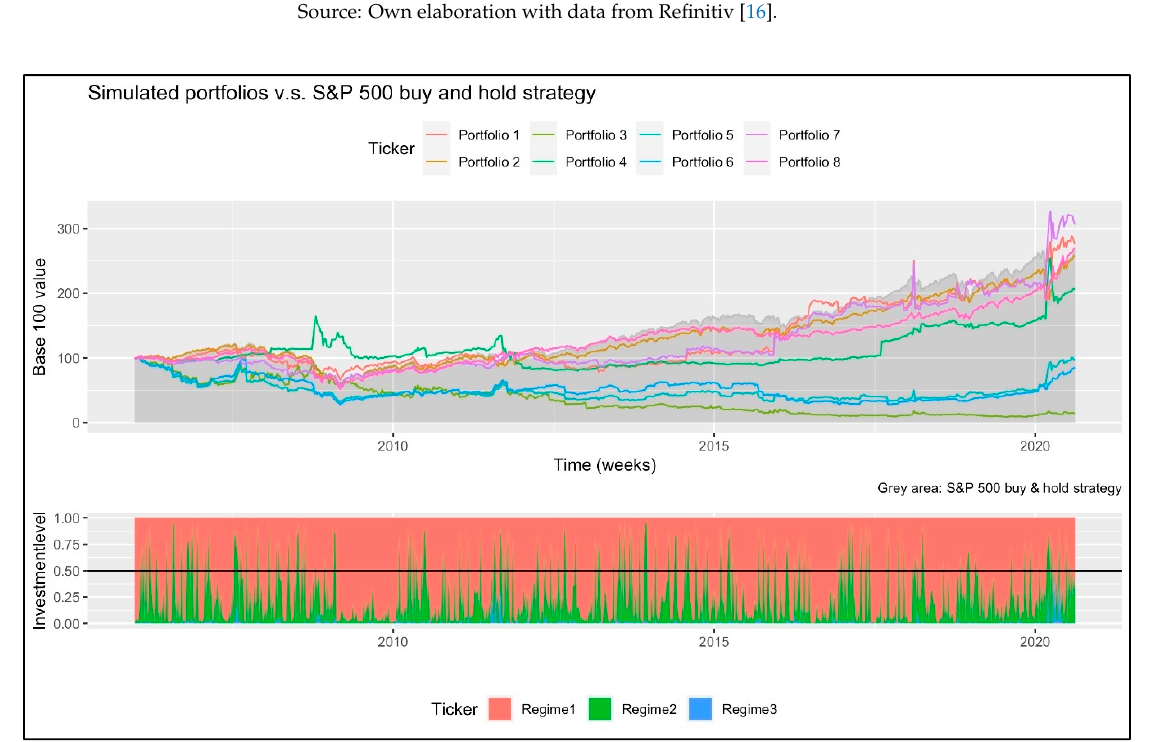
Figure 3. The historical performance of the 8 simulated portfolios of a theoretical investor that pays VIX future roll-over costs and has no stock trading fees. Source: Own elaboration with data from Refinitiv [16].